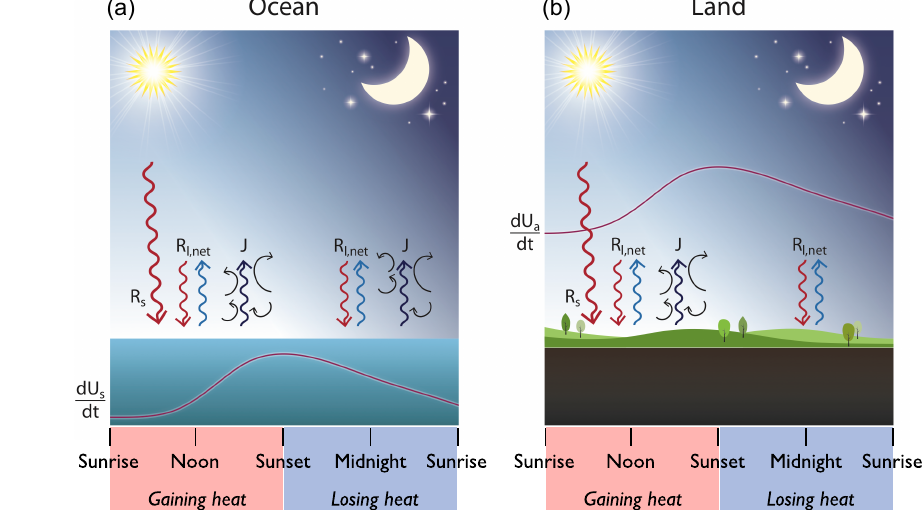
Figure 1. Schematic diagram of the surface energy balance of (a) an ocean surface and (b) the land surface. The main point to explain the different temperature sensitivity is related here to the different way by which these surfaces buffer the diurnal variation in solar radiation ( R s ). The ocean surface buffers it by heat storage changes below the surface in the upper ocean (shown by the red line labeled d U s / d t ), while the land surface buffers it primarily in the lower atmosphere (shown by d U a / d t ). This results in stable conditions over land during nighttime, which prevent turbulent fluxes ( J ) and which make surface temperature more sensitive to changes in the greenhouse effect. Graphics: Annett